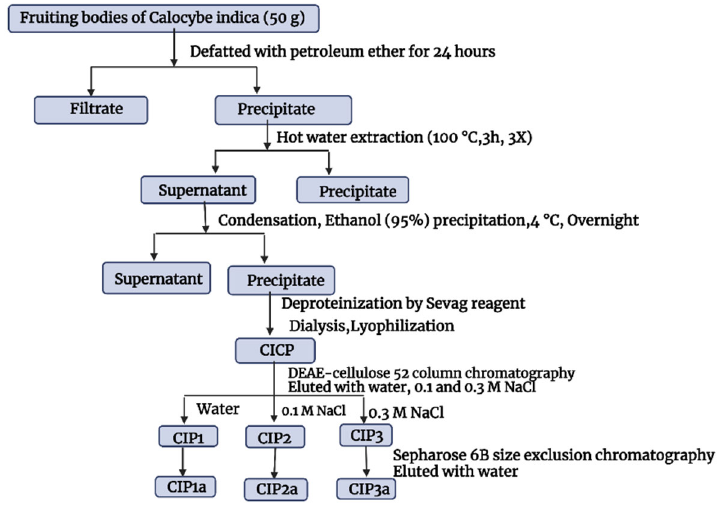
Figure 1. Extraction and purification of Calocybe indica